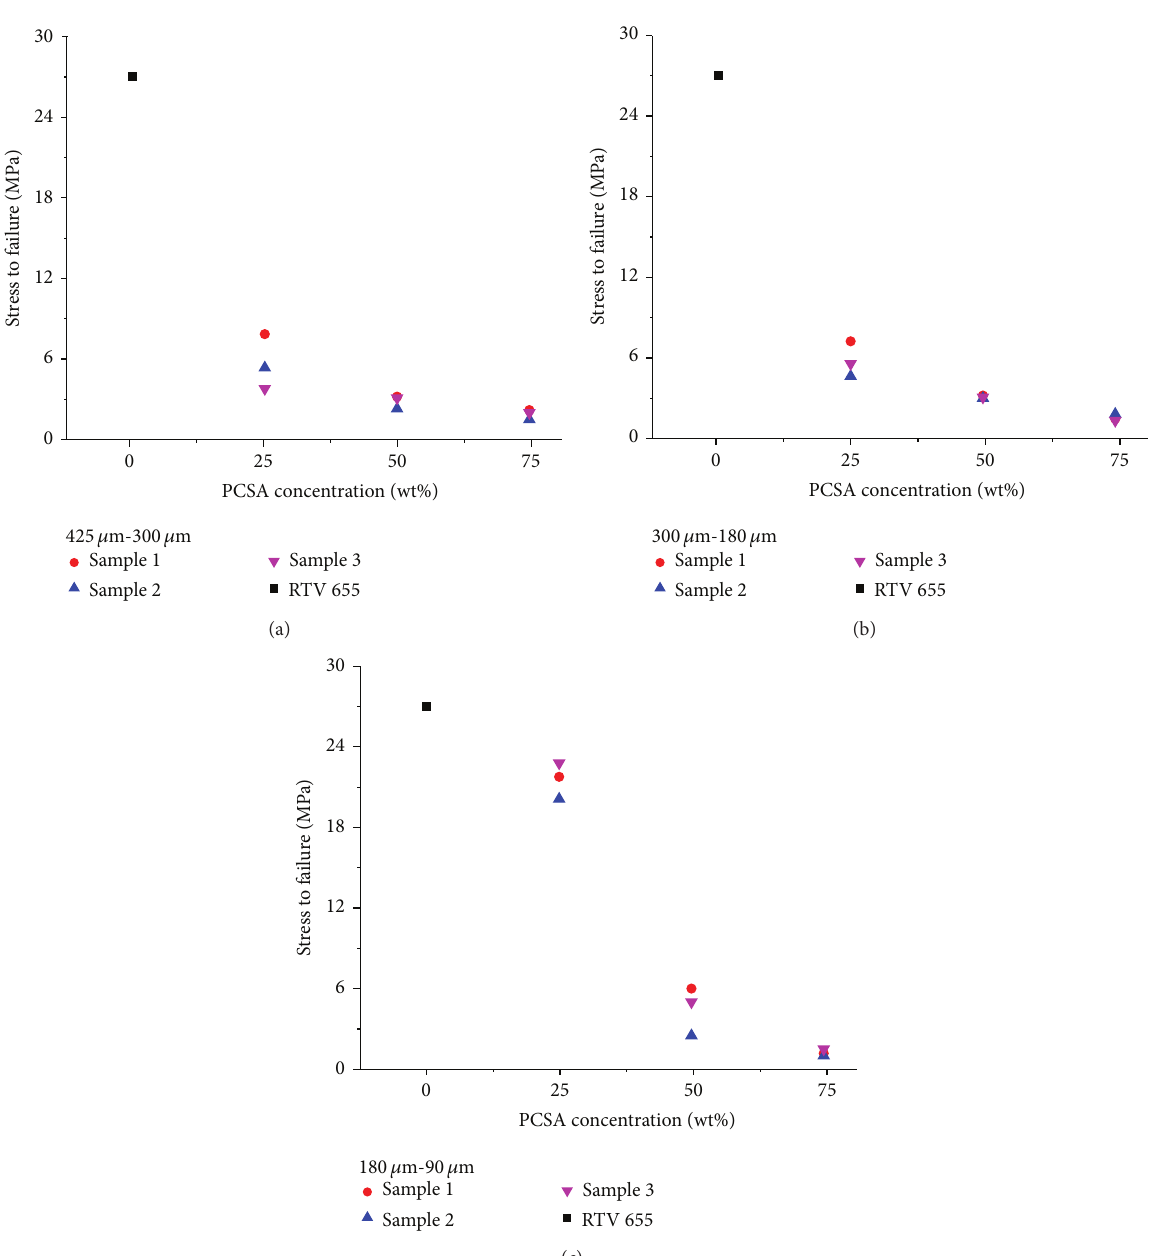
Figure 6: Rupture load of RTV 655+PCSA compound specimens at 77 K impregnated with three particle size ranges: (a) 𝑑 1 = 300–425 𝜇 m, (b) 𝑑 2 = 180–300 𝜇 m, and (c) 𝑑 3 = 90–180 𝜇 m measured for three separate sample batches. A similar trend of reduction in the yield strength compared to room temperature measurements was observed. However, a considerable amount of stiffness of both neat RTV 655 and compound specimens was